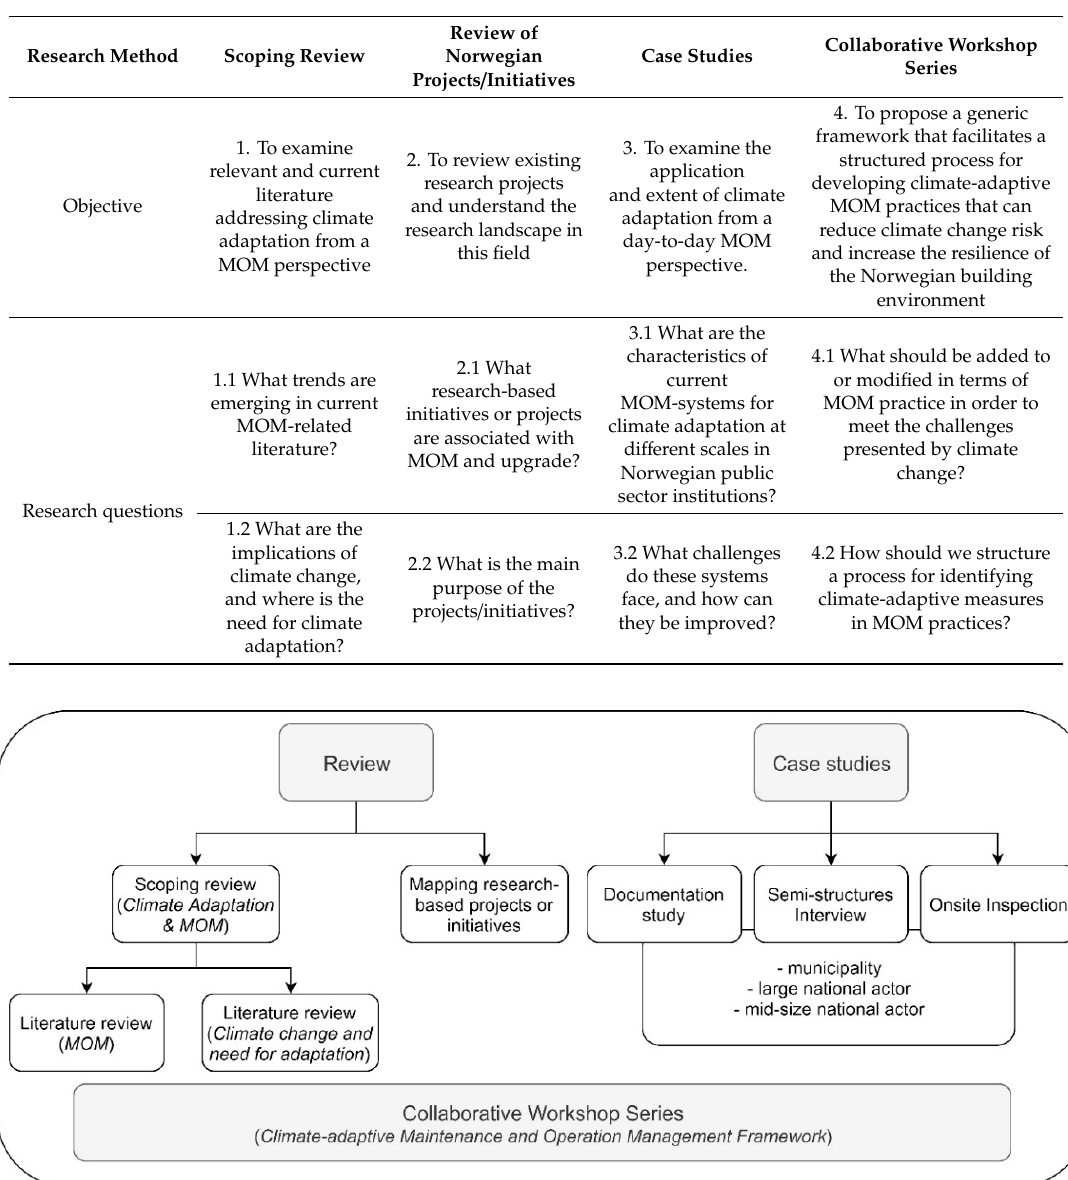
Table 1. Overview of methods, objectives, and research questions.